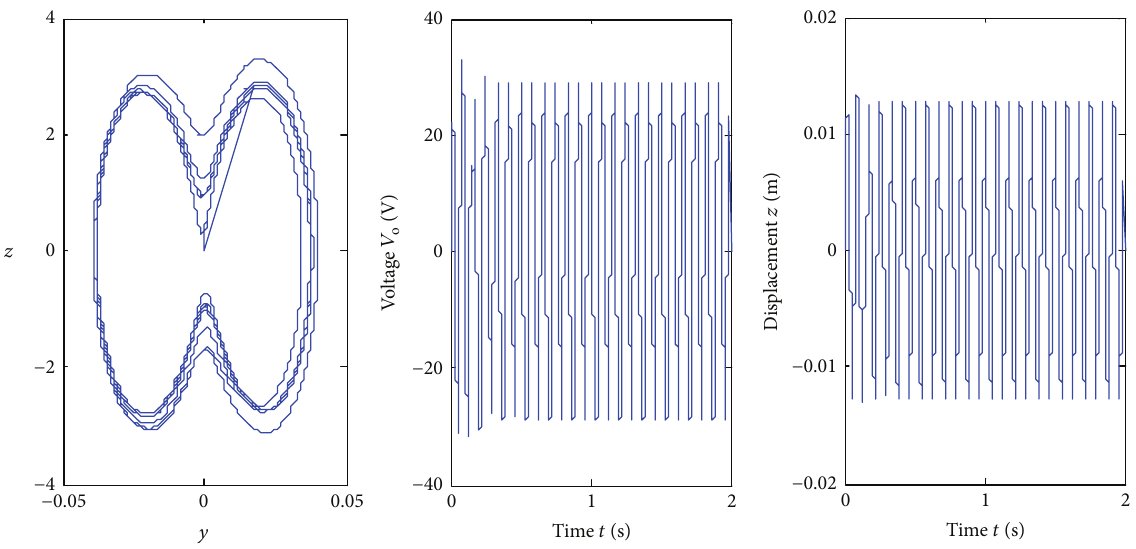
Figure 8: A large-amplitude motion across two stable positions when 𝑓 = 12